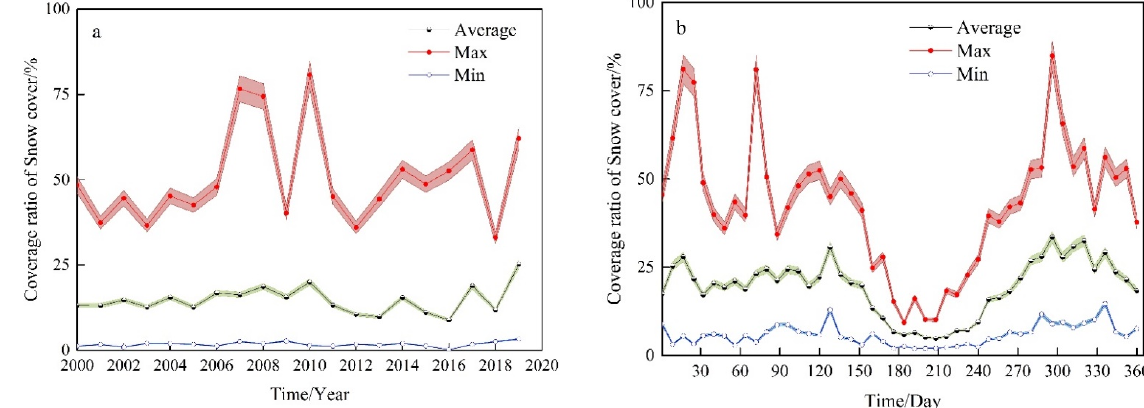
Figure 3. Variations in snow cover range in the upstream region of the Shule River catchment: ( a ) interannual variation; ( b ) 8-day interval variation.